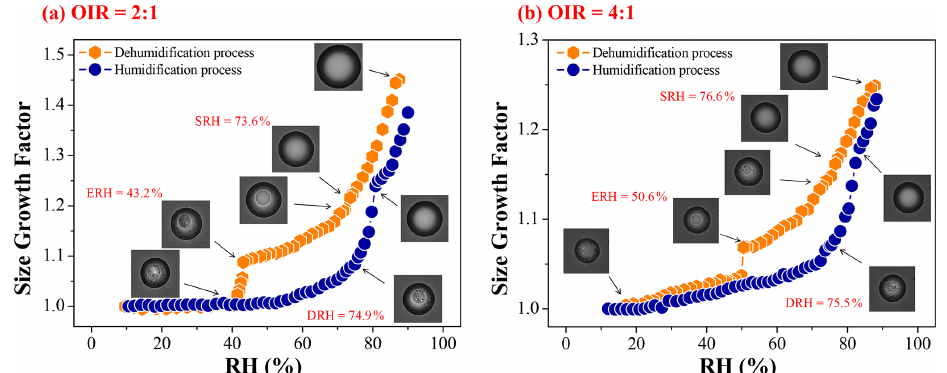
Figure 6. Hygroscopic cycles of mixed 1, 2, 6-hexanetriol / AS particles with OIR = 2 : 1 (a) and 4 : 1 (b) . The panels show the optical images corresponding to the GFs at a particular RH. The SRH, ERH and DRH values are given in red.